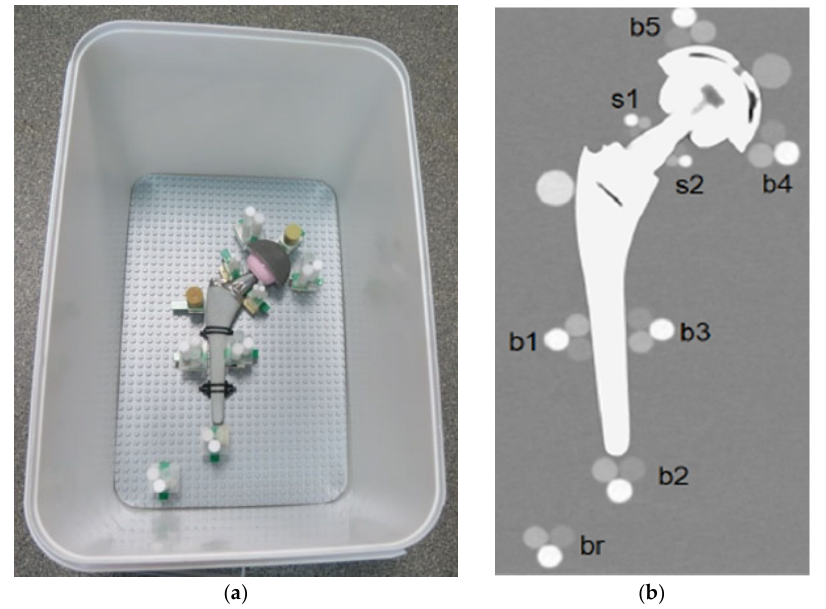
Figure 2. ( a ) Pellets positions around the prosthesis, TI configuration; ( b ) Coronal reconstruction.